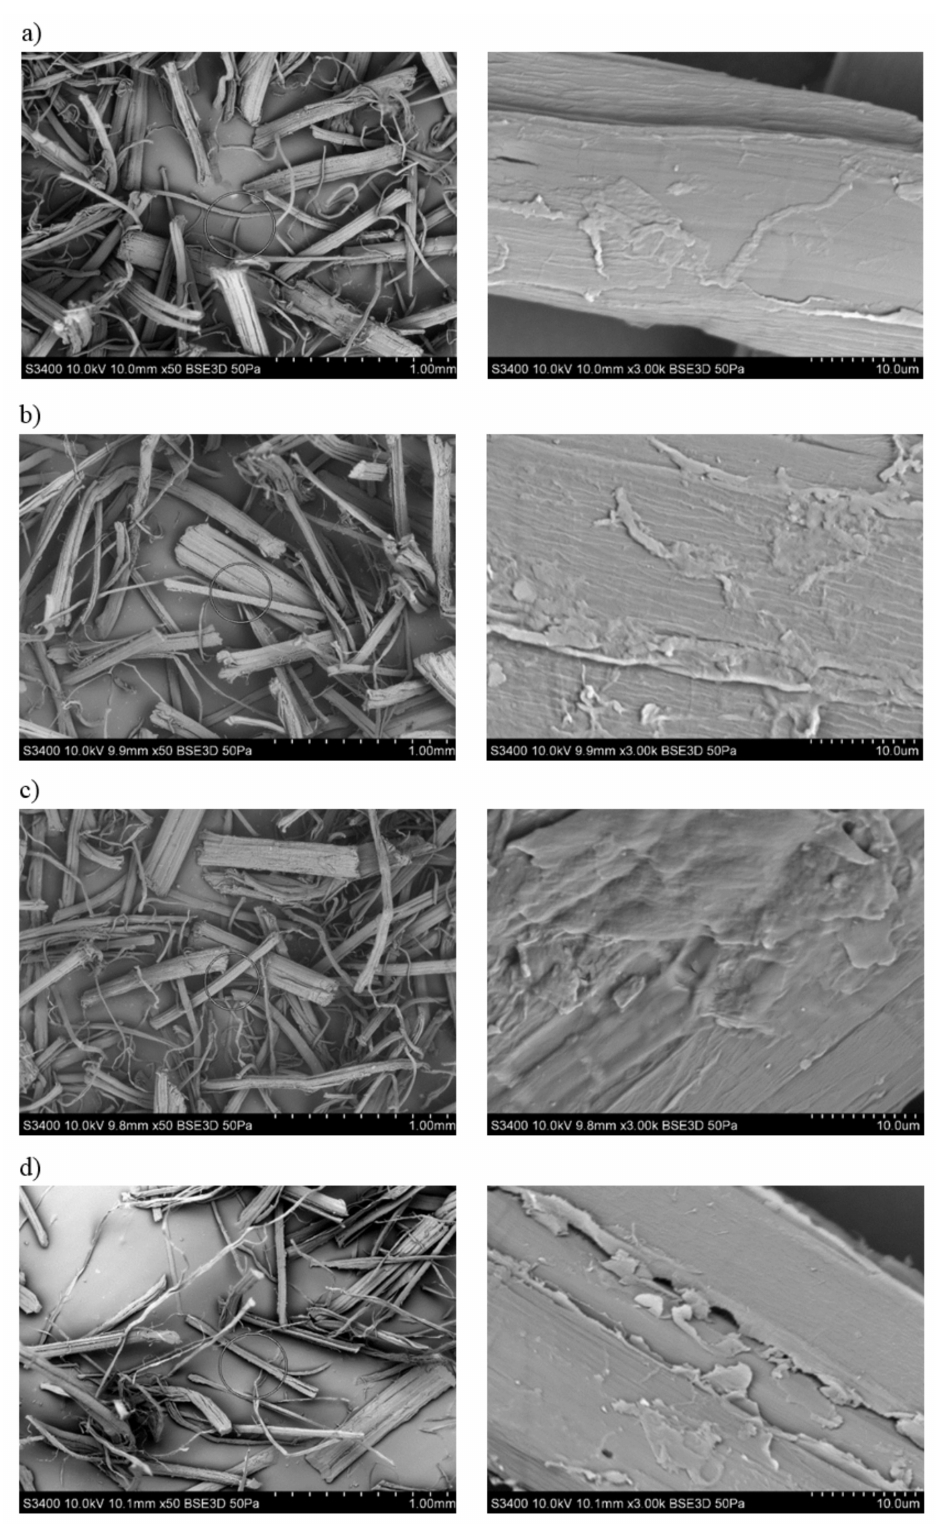
Figure 3. SEM photographs of hemp fibers: ( a ) unmodified, ( b ) exposed to 2% NAOH solution, ( c ) exposed to 5% NAOH solution, ( d ) exposed to 10% NAOH solution. By analyzing the SEM images of flax fibers (Figure 4), an increase in the degree of surface development after treatment with NaOH solution can be observed. When treating the fibers with a 5% solution and especially with 10%, the fibers lose their